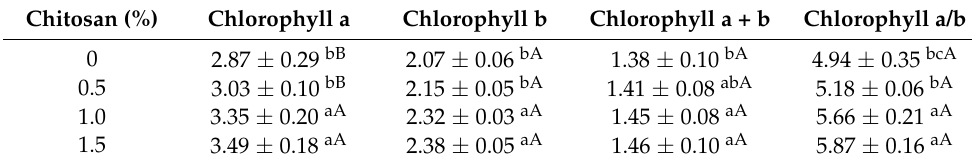
451.55 ± 6.11 a Values indicate the mean ± SD of three replicates. Different small letters indicate significant differences at 5% level ( p < 0.05).